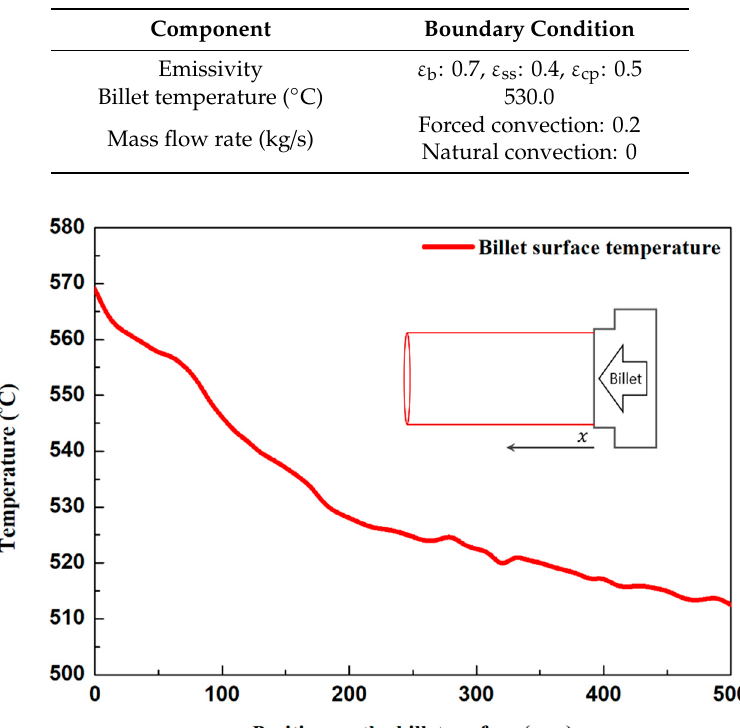
Table 5. Analysis of boundary conditions.